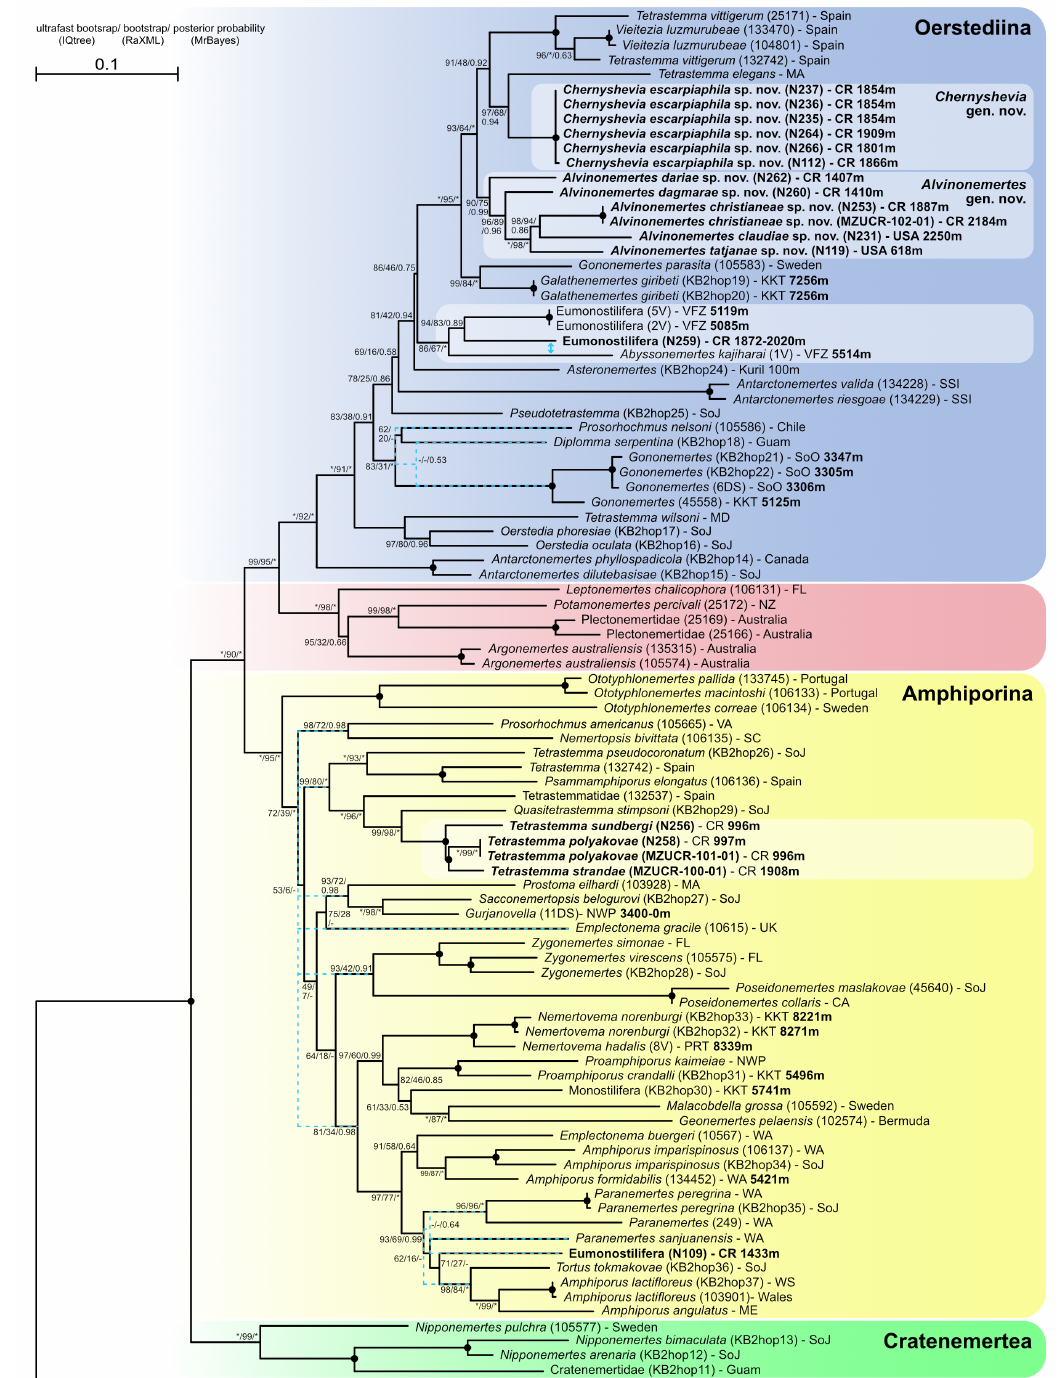
Fig. 7. Maximum likelihood (ML) tree for the monostiliferan supermatrix based on the concatenated four gene dataset (16S, COI, 18S, H3). Black circles indicate nodal support of 100/100/1.0; asterisks indicate nodal support of either 100/ or /1.0. Alternative branches found in the BI analysis are given as blue dotted lines. Sonnenemertes cantelli Chernyshev, Abukawa & Kajihara, 2015 and Micrura callima Sundberg & Gibson, 1995 were used for outgroup rooting. Specimens belonging to new species are given in bold. Specimen-ID, sampling locality, and depth (for deep-sea species) are